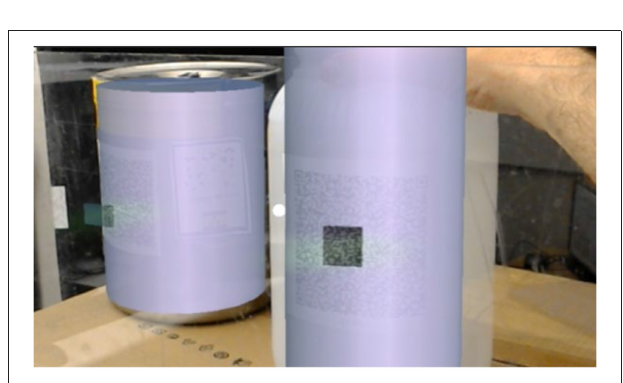
FIGURE 18 | Once the canisters pass a predefined proximity threshold, the holographic canisters turn blue to give the operator notice they have violated the criticality safety postings.